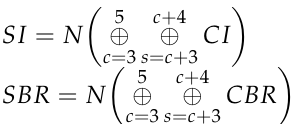
Figure 5. Performance comparison of SLIC with variant K and m of superpixels. These pictures are the superpixel images of a local region in a US breast image. The superpixel segmentation of the original image is shown in Figure 6b. ( a ) ( b ) Figure 6. Superpixel image obtained by SLIC: ( a ) Original image. ( b ) Superpixel image . 2.3.2. Superpixel Saliency Map The superpixel saliency map is computed as  